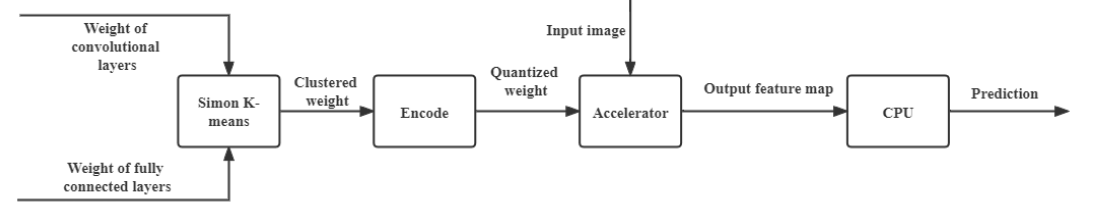
Figure 2. Overview of the design.